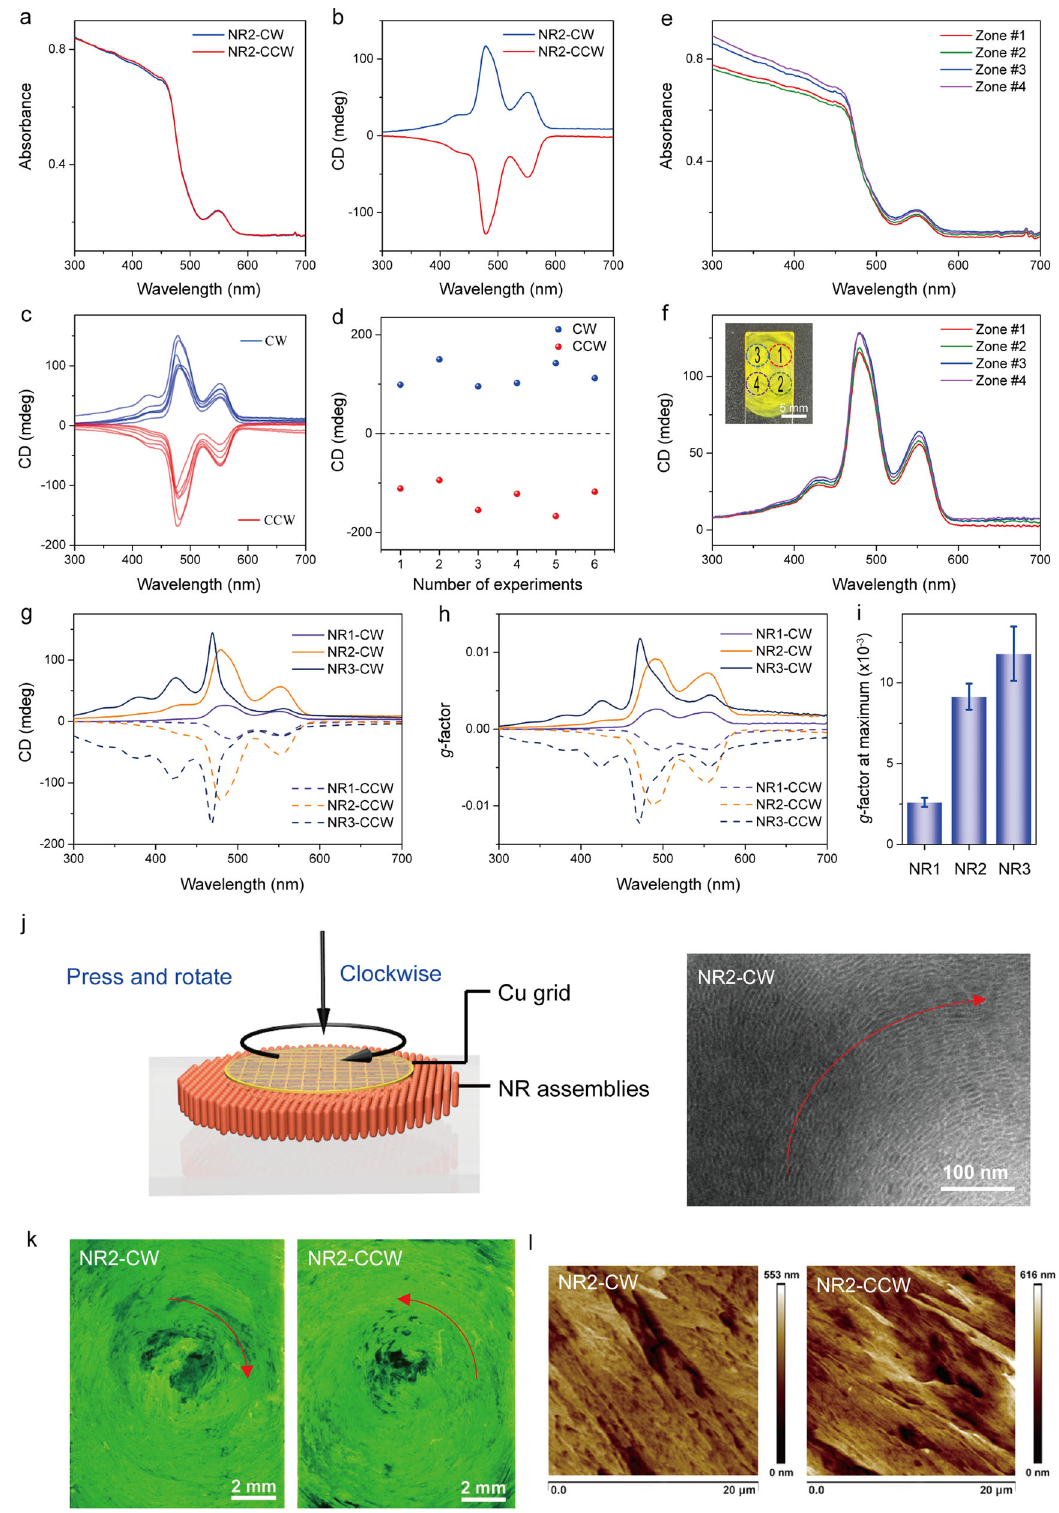
Fig. 2 | Chiral CdSe-CdS NRs assemblies generated mechanically. a UV − Vis absorption spectra and b CD spectra of NR2-CW (blue) and NR2-CCW (red) assemblies. c CD spectra of NR2-CW (blue) and NR2-CCW (red) assemblies pro- duced from independent experiments. d CD values at 480nm for various NR2- CW(blue)andNR2-CCW(red)assembliesfrompanel( c ). e UV − Visabsorptionand f CD spectra of NR2-CW assemblies at four distinct regions of a same quartz substrate. CD spectra ( g ) and the corresponding g-factor curves ( h ) of NR1, NR2